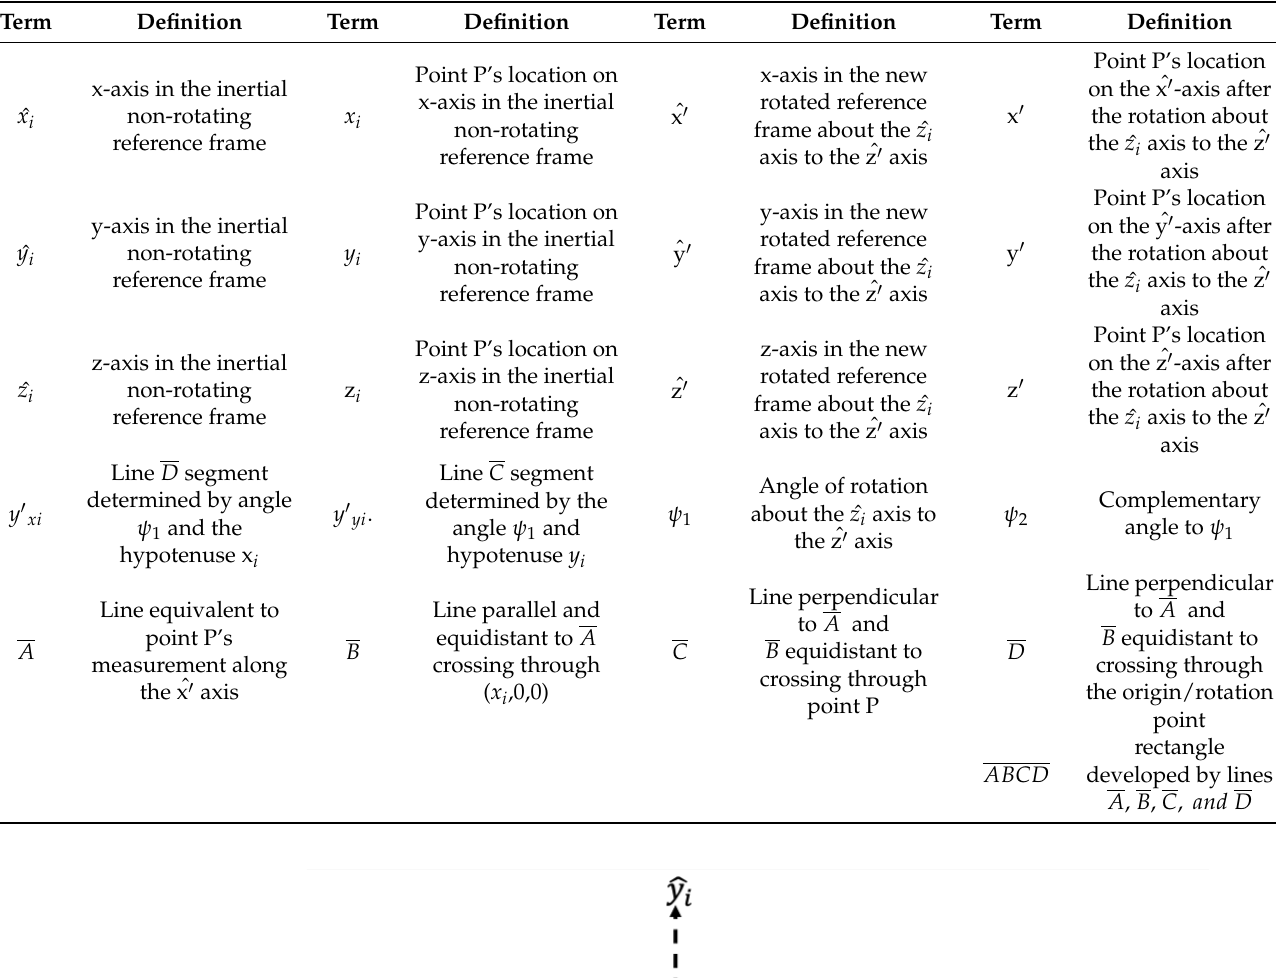
Table 3. Proximal variable and nomenclature definitions for Figures 13–15.